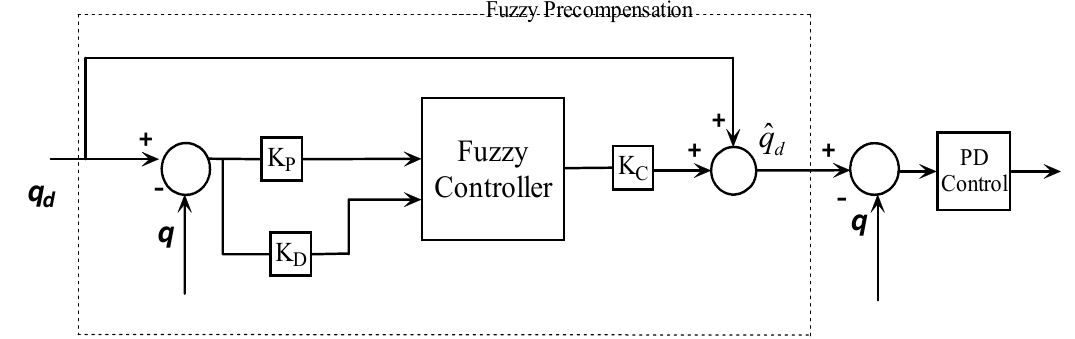
Fig. 2. Overall block diagram of the proposed hybrid controller.